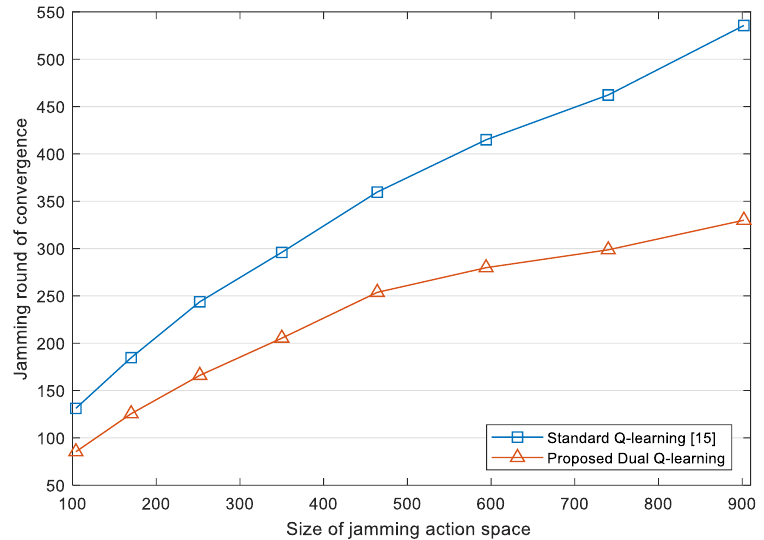
Figure 8. Convergence time comparison among different methods. The size of jamming action space is defined as the product of the total number of optional parameters in time and frequency